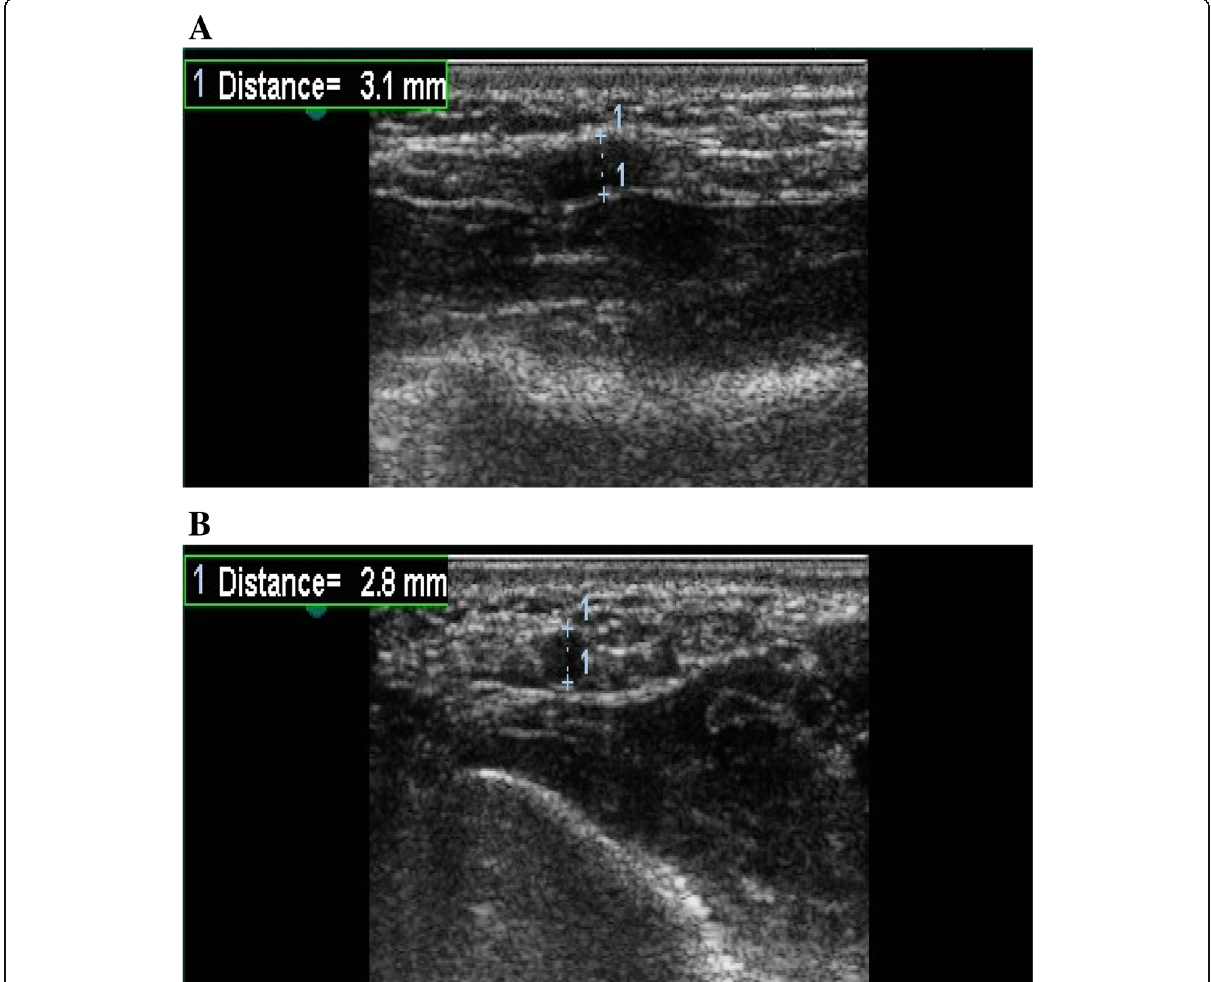
Fig. 1 Ultrasonography of the RA using the B-mode. a Diameter of the RA in the horizontal section. b Diameter of the RA in the longitudinal